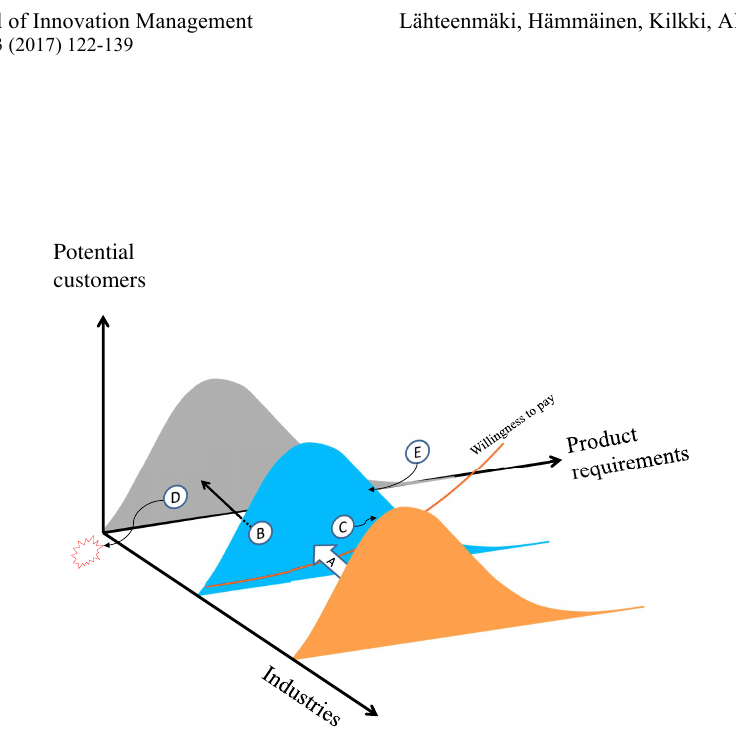
Fig 2. Model of disruption transition between industries (after Kilkki et al.,